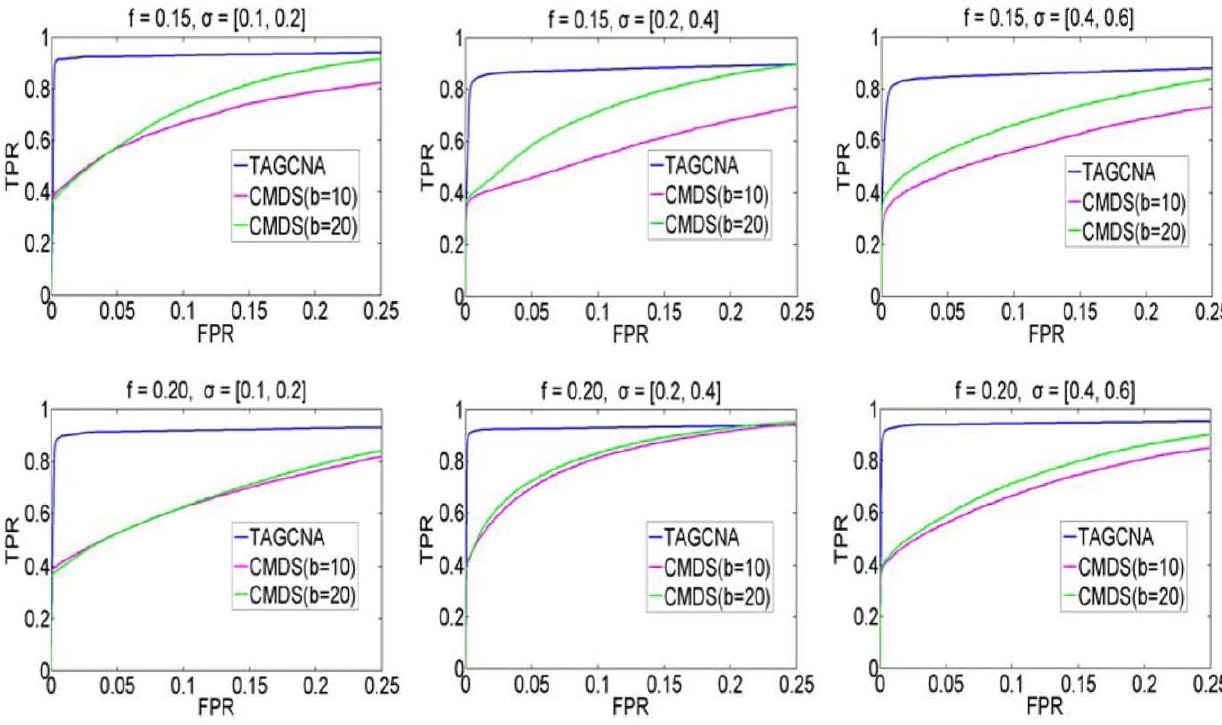
Figure 3. Performance comparison between CMDS and TAGCNA based on ROC curves. TPR and FPR are averaged over 100 simulated replications in each parameter setting. We use two options (i.e. b=10 and b=20) for the CMDS method in the data analysis.